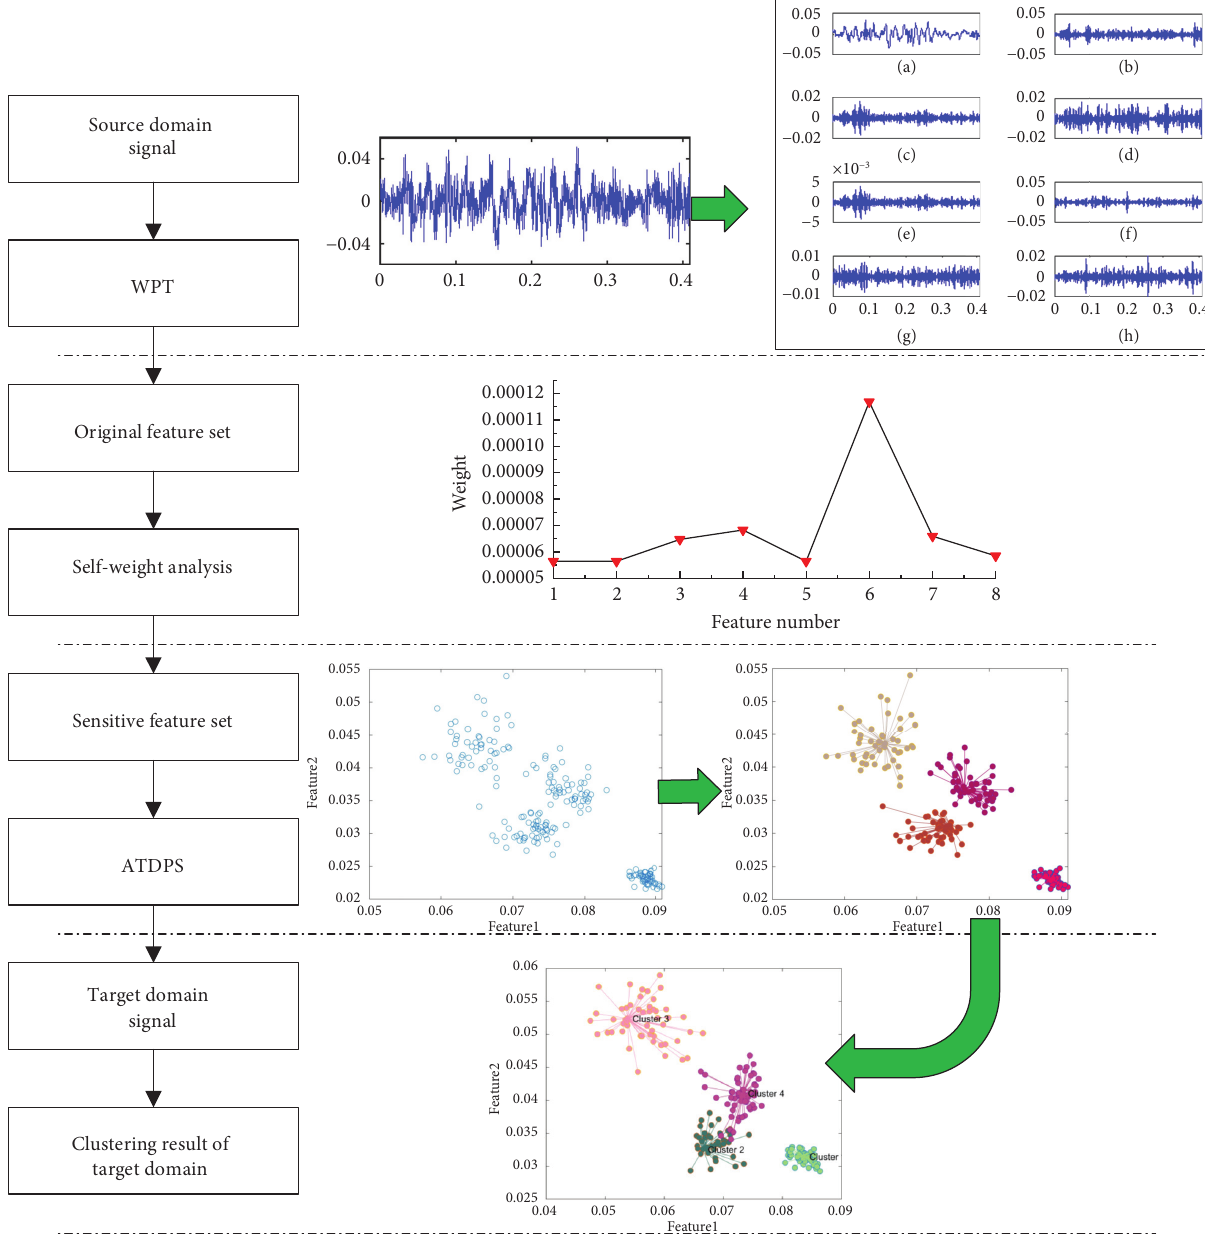
Figure 6: The flowchart and illustration of the proposed intelligent diagnosis